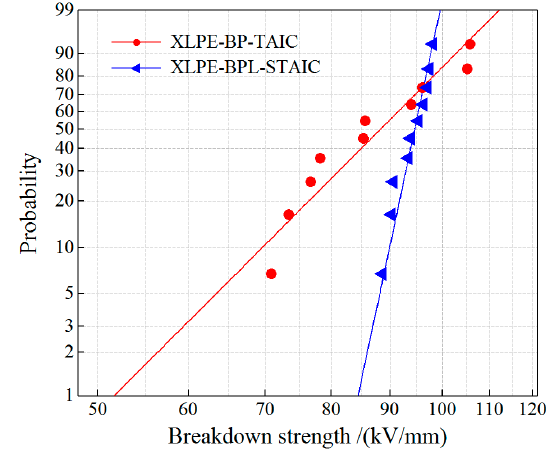
Figure 5. Dielectric breakdown strength statistics fitted with two ‐ parameter Weibull distribution for XLPE samples prepared by different photon ‐ initiation systems. Table 6. The characteristic 63.2% DBS and shape parameter of Weibull distribution fitted in 95% confidence interval for XLPE samples prepared with different photon initiators and auxiliary crosslinkers.